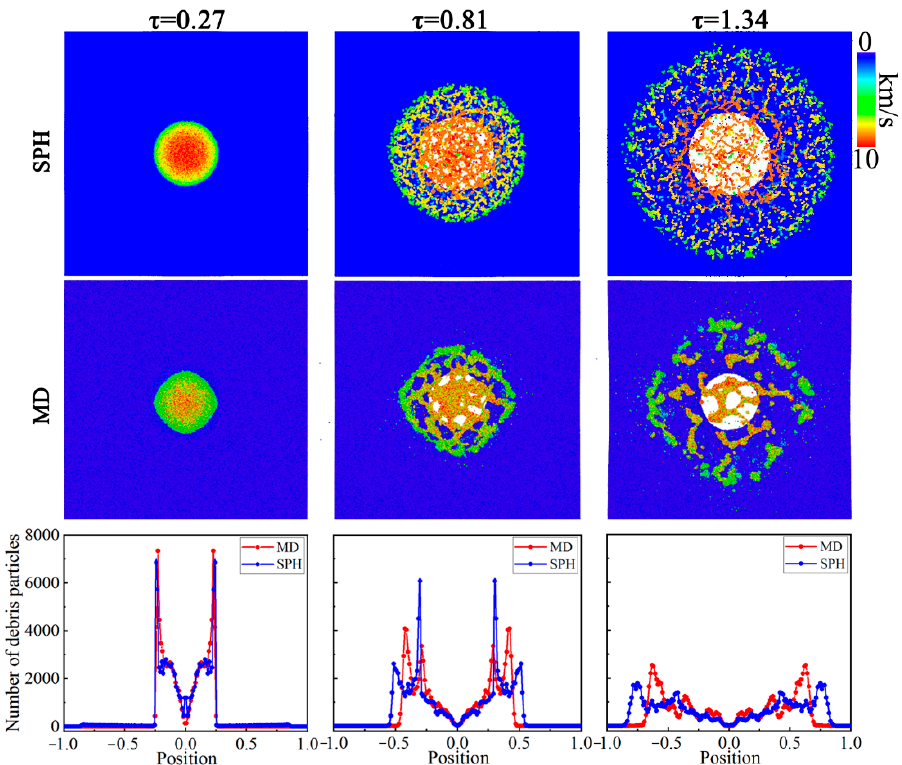
Figure 8. Schematic diagram ( a ) and flow chart ( b ) of the algorithm for solving the radial distribu- tion of debris particles.